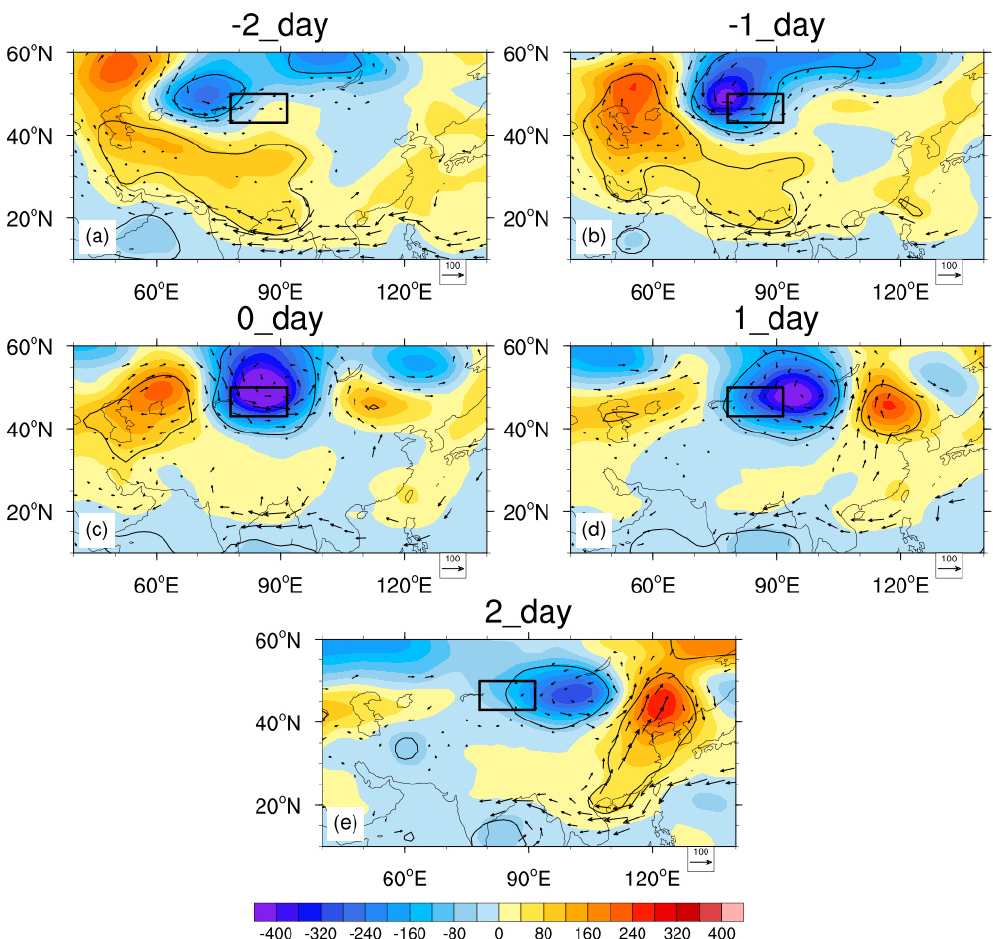
Figure 5. Composition of Z500 (contour) and Q anomaly (arrow) of Type NN on the extreme precipitation day and two days before and after ( a – e ) in summers of 1979–2018 (Unit: gpm). The black box represents the location of the Northern Xinjiang region. The region over the 95% significant confidence level of geopotential height is circled with black lines, and only the part over the 95% significant confidence level of surface water vapor flux is shown.